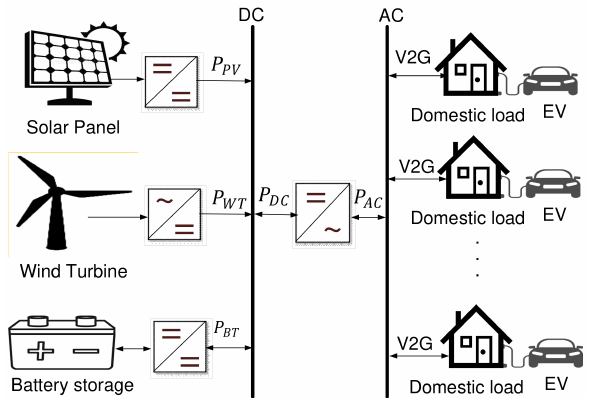
Figure 1. The architecture of the proposed hybrid